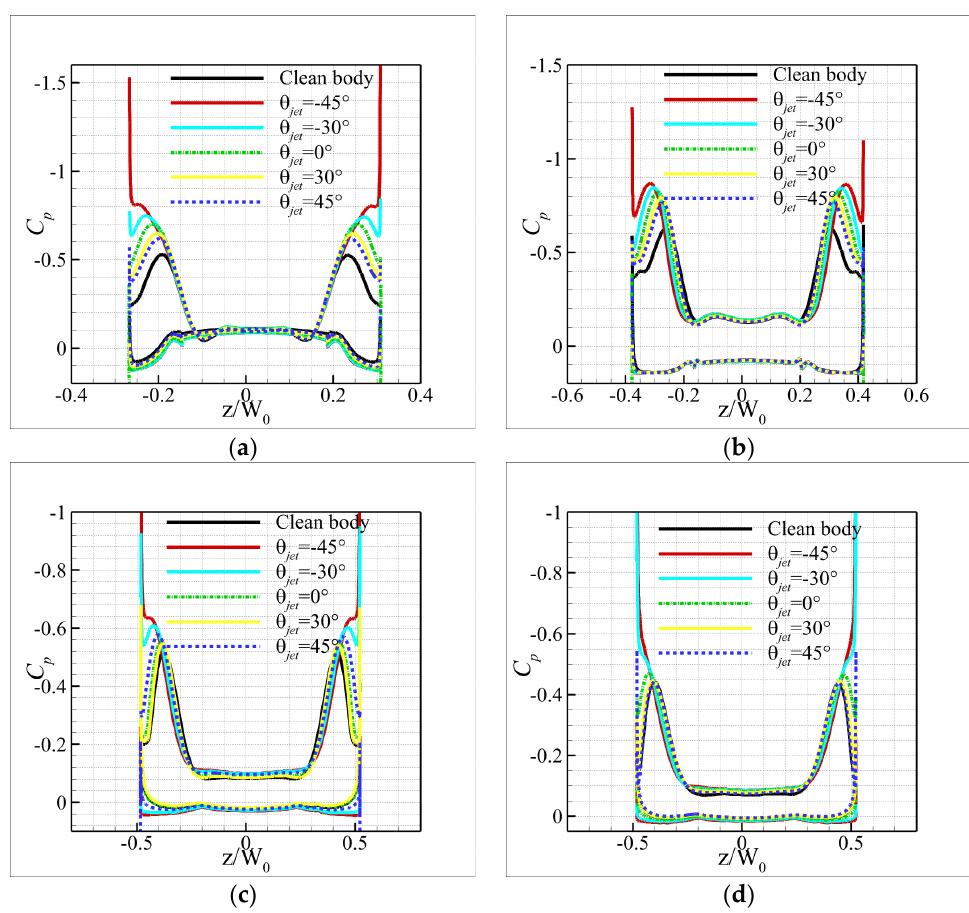
Figure 21. Changes in lift by the lateral jets with different blowing directions. ( a ) Lift coefficient; ( b ) Lift coefficient augmentation.